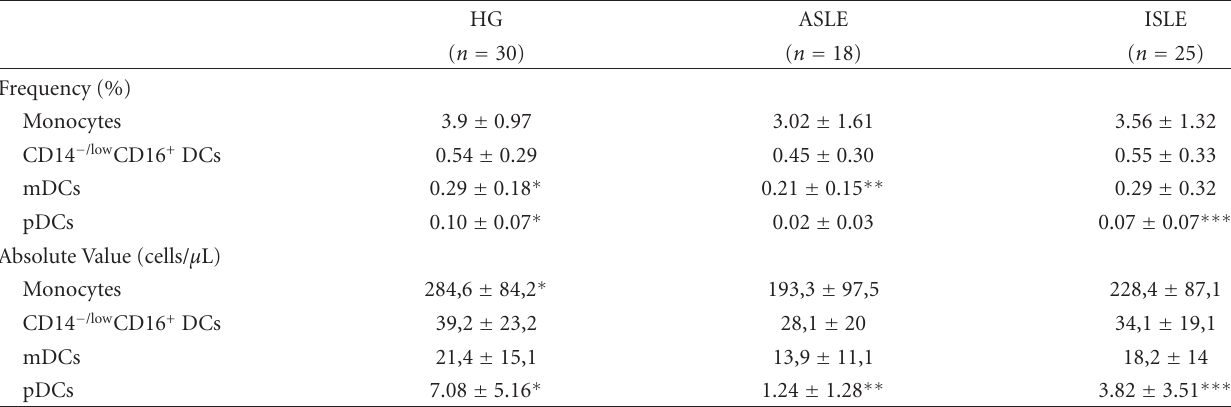
Table 2: Number of sorted monocytes and peripheral blood dendritic cells in the three studied groups (HG, ASLE, and ISLE). HG ASLE ISLE ( n = 30) ( n = 18) ( n = 25) Number of sorted cells Monocytes 143701 ± 110950 91029 ± 83915 115407 ± 10558 CD14 − /low CD16 + DCs 15393 ± 18486 9667 ± 11976 7251 ± 3903 mDCs 8709 ± 7107 4365 ± 3228 3771 ± 3076 pDCs 5281 ± 3894 1363 ± 1291 3416 ± 2655 HG: Healthy control group. ASLE: Active disease group. ISLE: Inactive disease group.